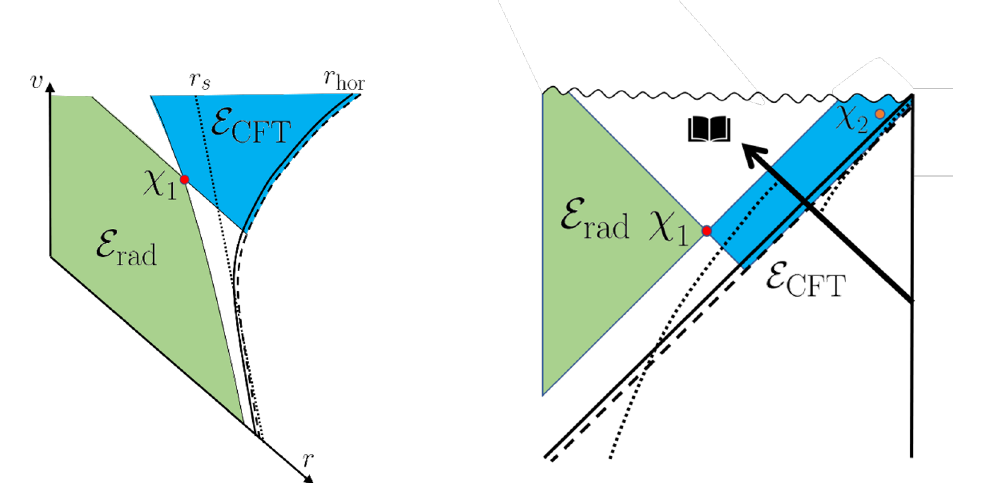
Figure 14. When a large diary is thrown into a black hole, the radius r hor of the event horizon (solid line) begins increasing in anticipation of the diary falling in, while the radius r s of the apparent horizon (dotted line) continues to slowly decrease until the diary is actually thrown into the black hole. As the black hole continues to evaporate, the past lightcone (dashed line) of the current boundary remains outside the event horizon. The Ryu-Takayanagi surface (cid:31) 1 asymptotes to a point approximately the scrambling time before the diary was thrown in. There is a second quantum extremal surface (cid:31) 2 at an infalling time after the diary is thrown in. Initially, this extremal surface is not the RT surface because its area is larger than the area of (cid:31) 1 . However, eventually, at the new Page time, there will be a phase transition, with (cid:31) 2 becoming the new RT surface, and the diary can (cid:12)nally be reconstructed from the Hawking radiation, so long as its entropy is small. (Left: Eddington-Finkelstein coordinates, right: a Penrose